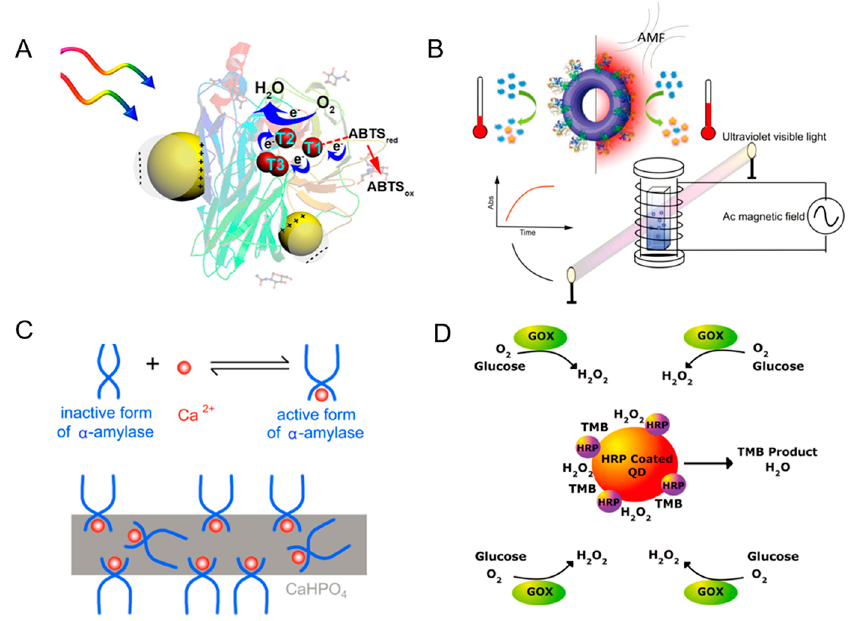
Figure 5. ( A ) Schematic of the Au–laccase hybrids with enhanced electron transfer. Reconstructed with permission from Ref. [23], Copyright (2015) American Chemical Society. ( B ) Illustration of the FVIO- β -Gal hybrids and the experimental set-up, the activities were tuned by AFM-triggered local heating. Reprinted with permission from Ref. [27]. Copyright (2019) RSC Pub. ( C ) The α -amylase- CaHPO 4 nanoflower nanobiocatalyst Ca 2+ binds to allosteric sites in inactive α -amylase and generates active α -amylase. Reproduced with permission from Ref. [17], copyright 2013, American Chemical Society. ( D ) Diagram of the GOX/HRP–CdSe/ZnS QDs system with enhanced coupled enzymatic activity. Reconstructed with permission from Ref. [59], copyright (2017) RSC Pub.